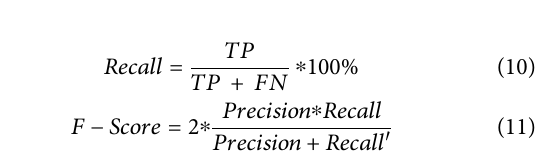
Frontiers in Energy Research |